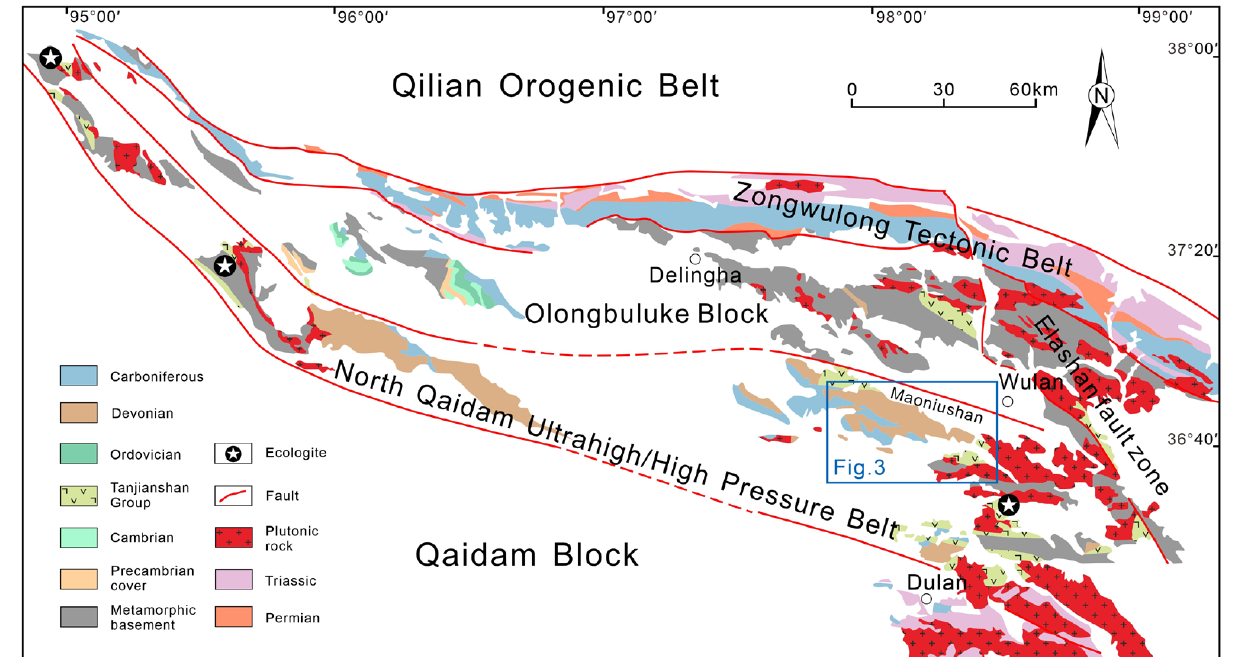
Figure 2. Diagram of the division of tectonic units in the NQ [80 ].